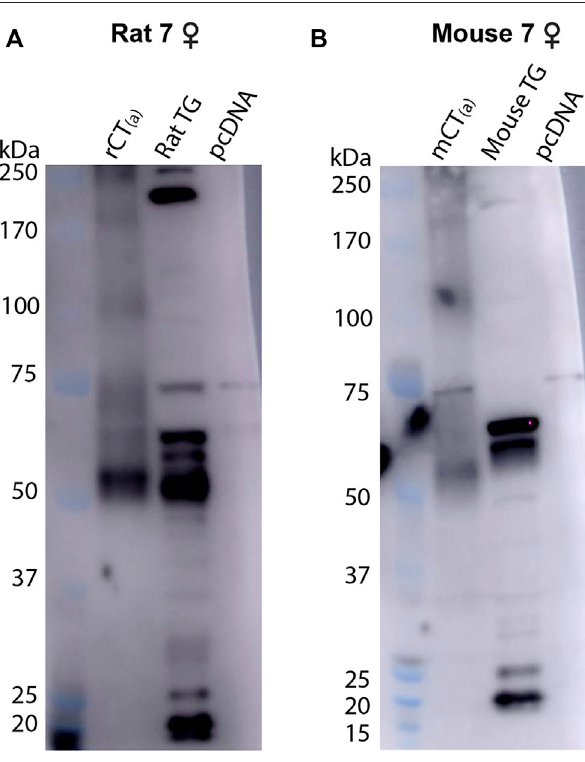
FIGURE 6 | CTR-like immunoreactivity in rat and mouse TG lysate using immunoblottingwithpAb188. (A) Immunoblotsusinglysatepreparationsfrom adult rat TG (20 µg) and HEK293S cells (0.1 µg) transfected with rat CT (a) or vector alone (pcDNA). (B) Immunoblots using lysate preparations from adult mouse TG (20 µg) and HEK293S cells (0.3 µg) transfected with mouse CT (a) or vector alone. Blots were probed with pAb188 (4 µg/ml). MW markers are shown on the left of each blot, with apparent MW in kDa. This image is representative of three western blots using TG lysate from three individual miceorrats(mixedsex)displayingresultsfromafemale (A) ratand (B) mouse. Images were adjusted uniformly for brightness and contrast for presentation